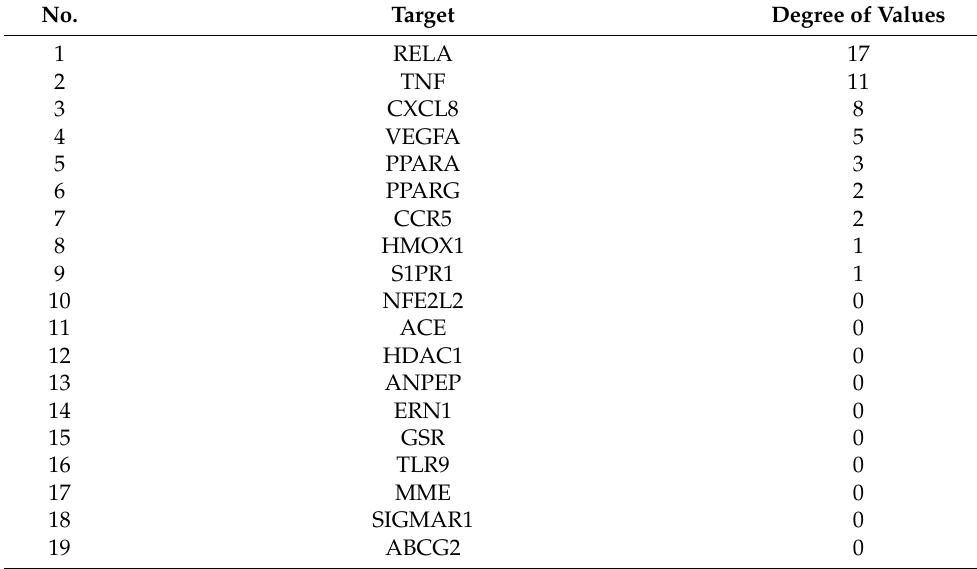
Table 4. The degree value of targets in the STB